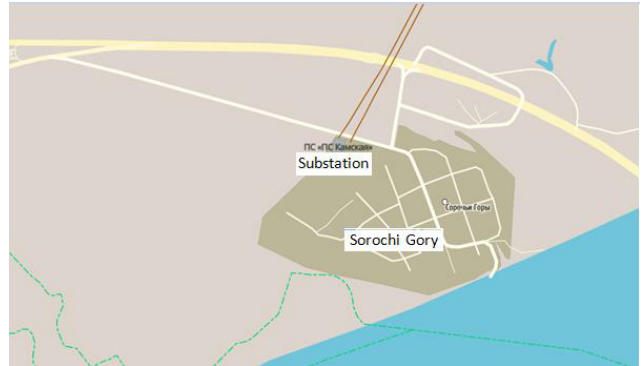
Figure 6. Map showing the substation in Sorochi Gory